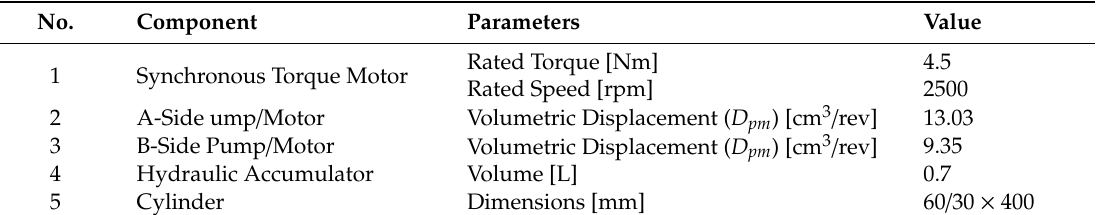
Figure 1. The hydraulic circuit of the test bench. Table 1. Main parameters of the components in the setup.